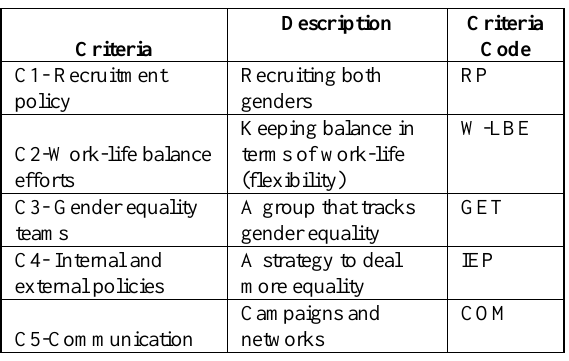
Table 1: Gender Equality Criterias